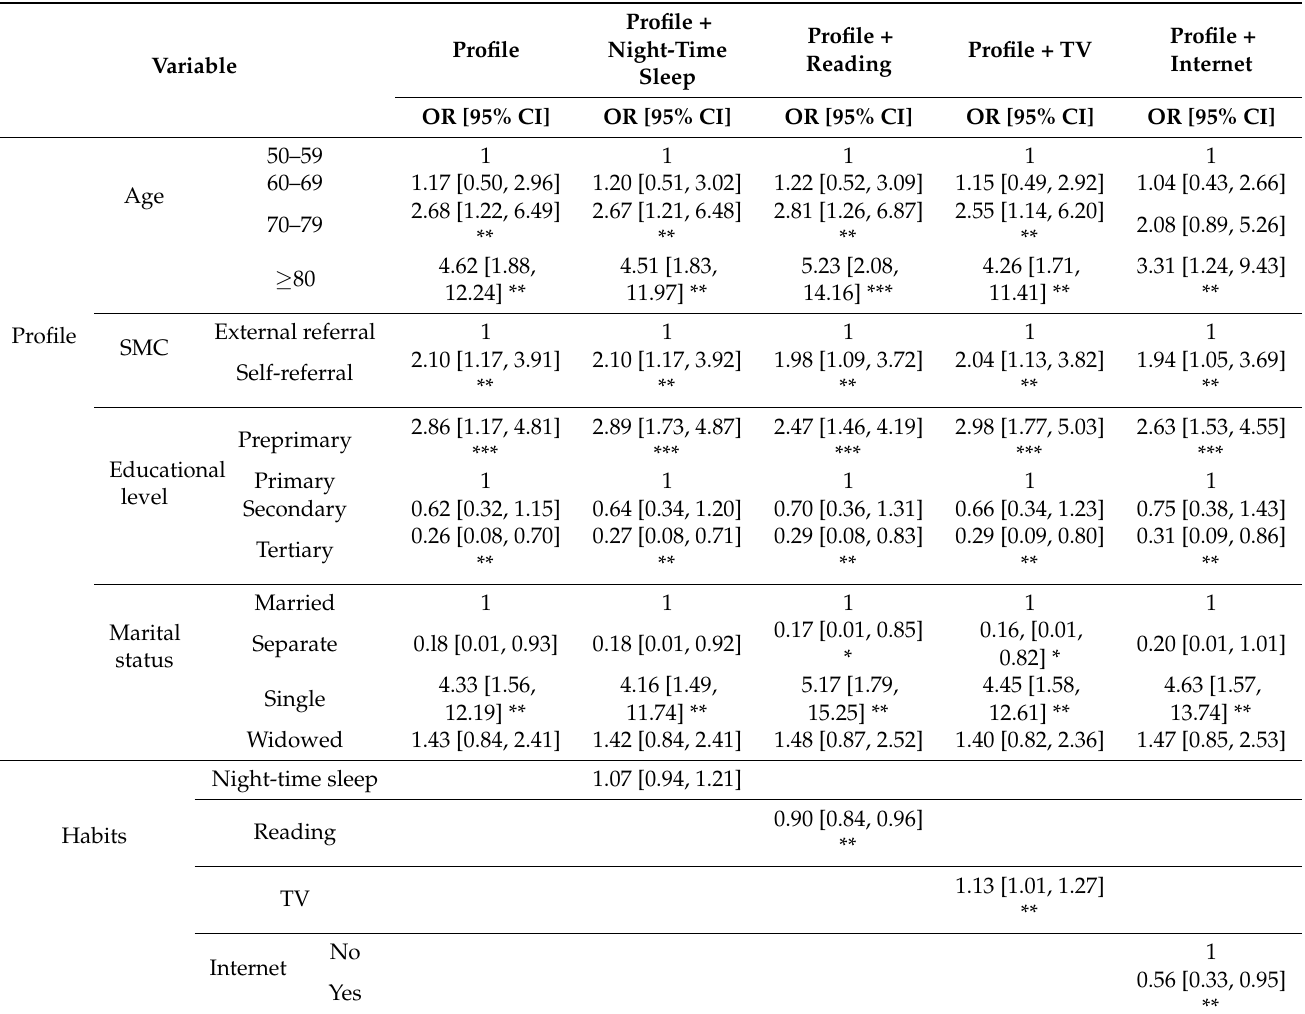
Table 7. Multivariate logistic regression models on the patient profile and each of the significant life habits (*: p -value < 0.1; **: p -value < 0.05; ***: p -value <